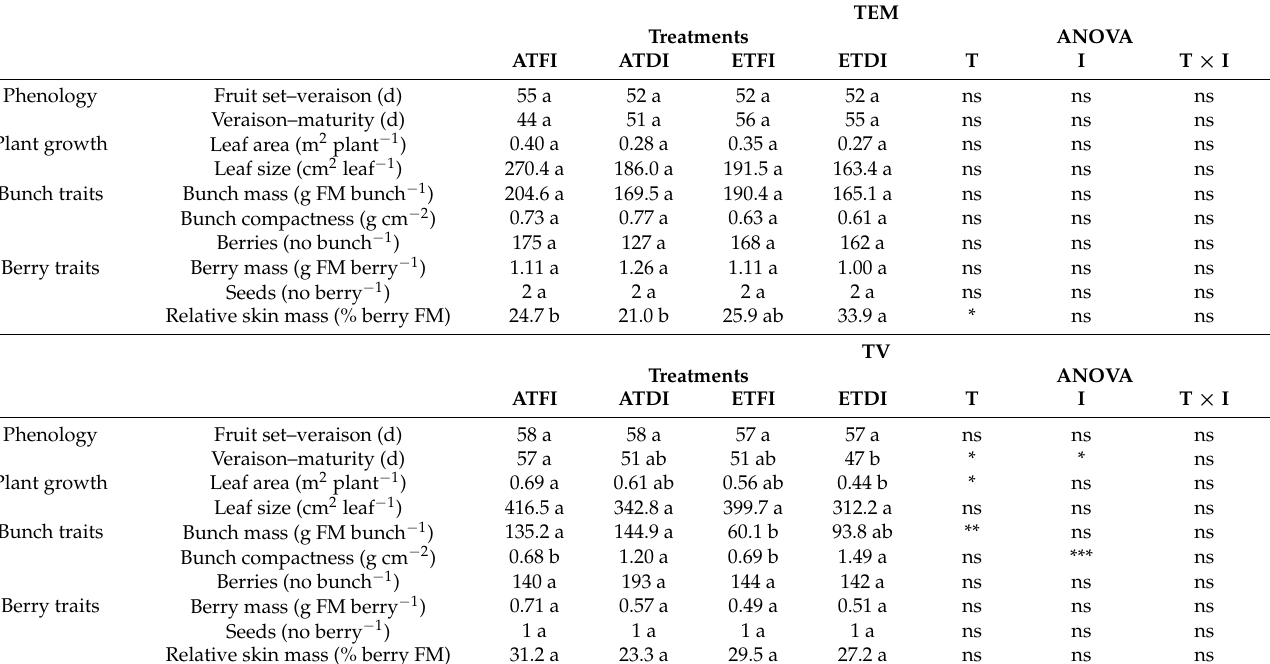
Table 3. Phenology, plant growth, and fruit characteristics from fruit-bearing cuttings of different ancient wine grape varieties grown either at ambient (AT) or elevated temperature (ET) and subjected to different irrigation regimes (FI, full irrigation; DI, deficit irrigation). The variety labels can be found in Table